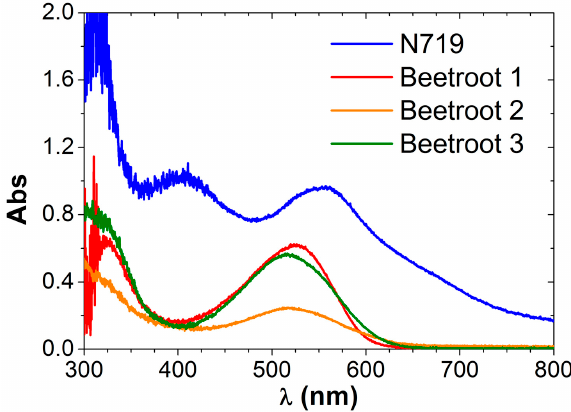
Figure 5. Betalains from beetroots: three pigment extracts with solvent solutions 1, 2 and 3.